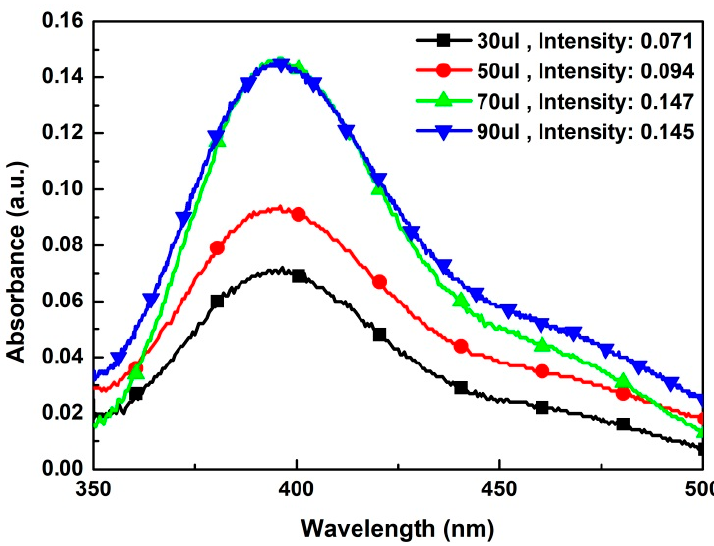
Figure 2. Light absorbance spectra of GNP solutions obtained at different HNO 3 additions of 30, 50, 70, and 90 μ L within a growth solution.